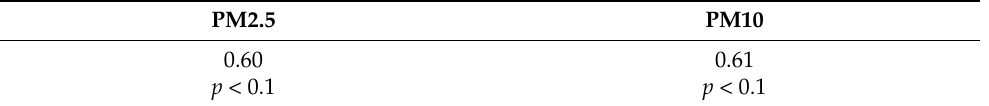
Table 9. Correlations for the averages from dust measurements outside and inside the building.